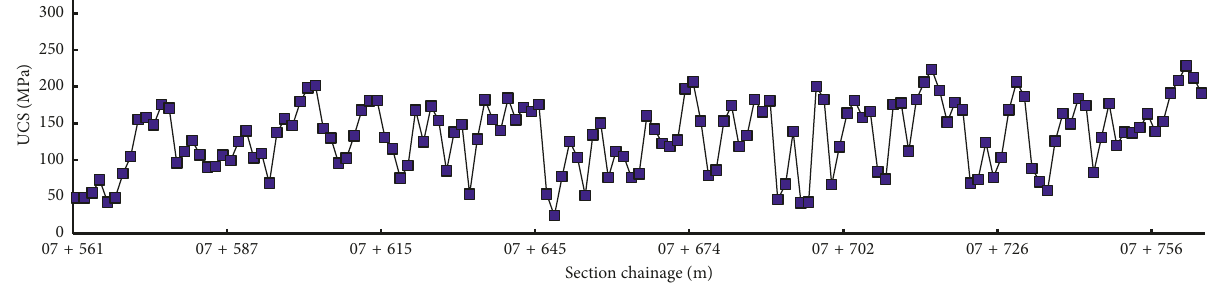
Figure 11: UCS values from laboratory tests along the Neelum–Jhelum TBM diversion tunnel.